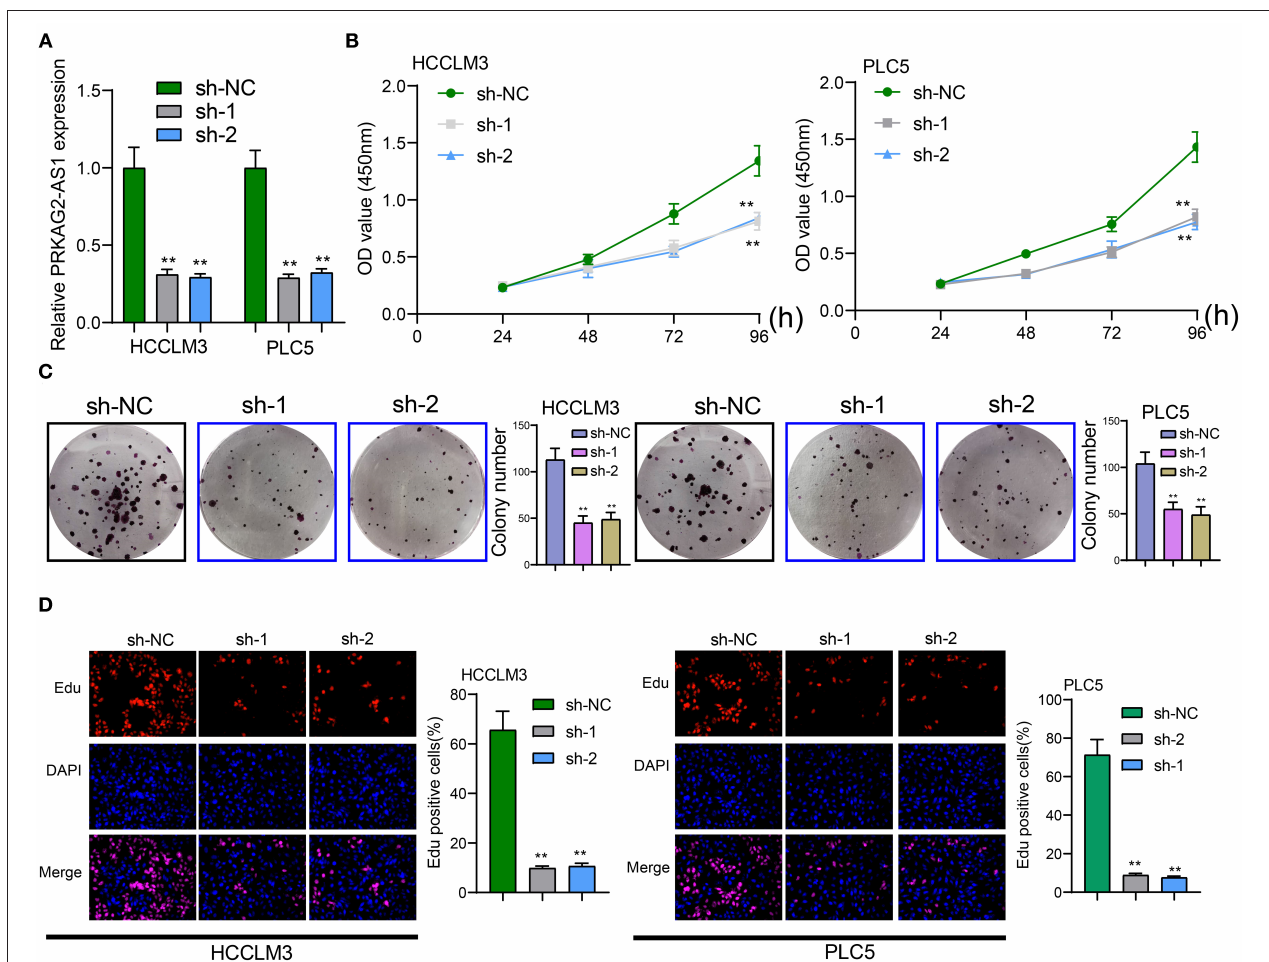
FIGURE 2 | Targeting PRKAG2-AS1 inhibits proliferative capacity of HCC cells. (A) RT-qPCR confirmed the successful suppression of PRKAG2-AS1 expression by two shRNAs. (B) CCK-8 for examining the relative cell viability of HCC cells after transfection with shRNAs for 48, 72, and 96h. (C) The colony formation was evaluated for HCCLM3 and PLC5 cells with PRKAG2-AS1 knockdown. (D) Representative images of EdU staining for HCC cells with PRKAG2-AS1 knockdown. ** p <